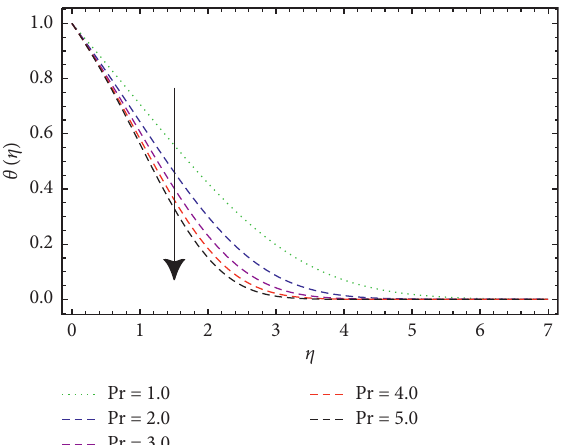
Figure 13: Influence of the θ ( η ) profile via Pr.